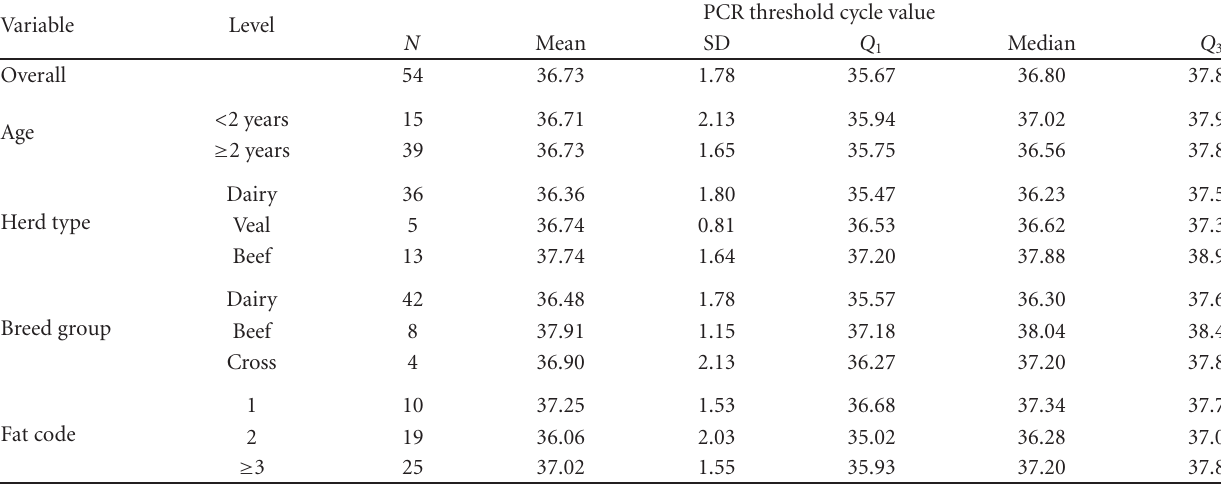
Table 2: Summary of threshold cycle value of IS 900 PCR to detect Mycobacterium avium subsp. paratuberculosis DNA in beef carcasses by age, herd type, breed group, and fat code of the cattle.